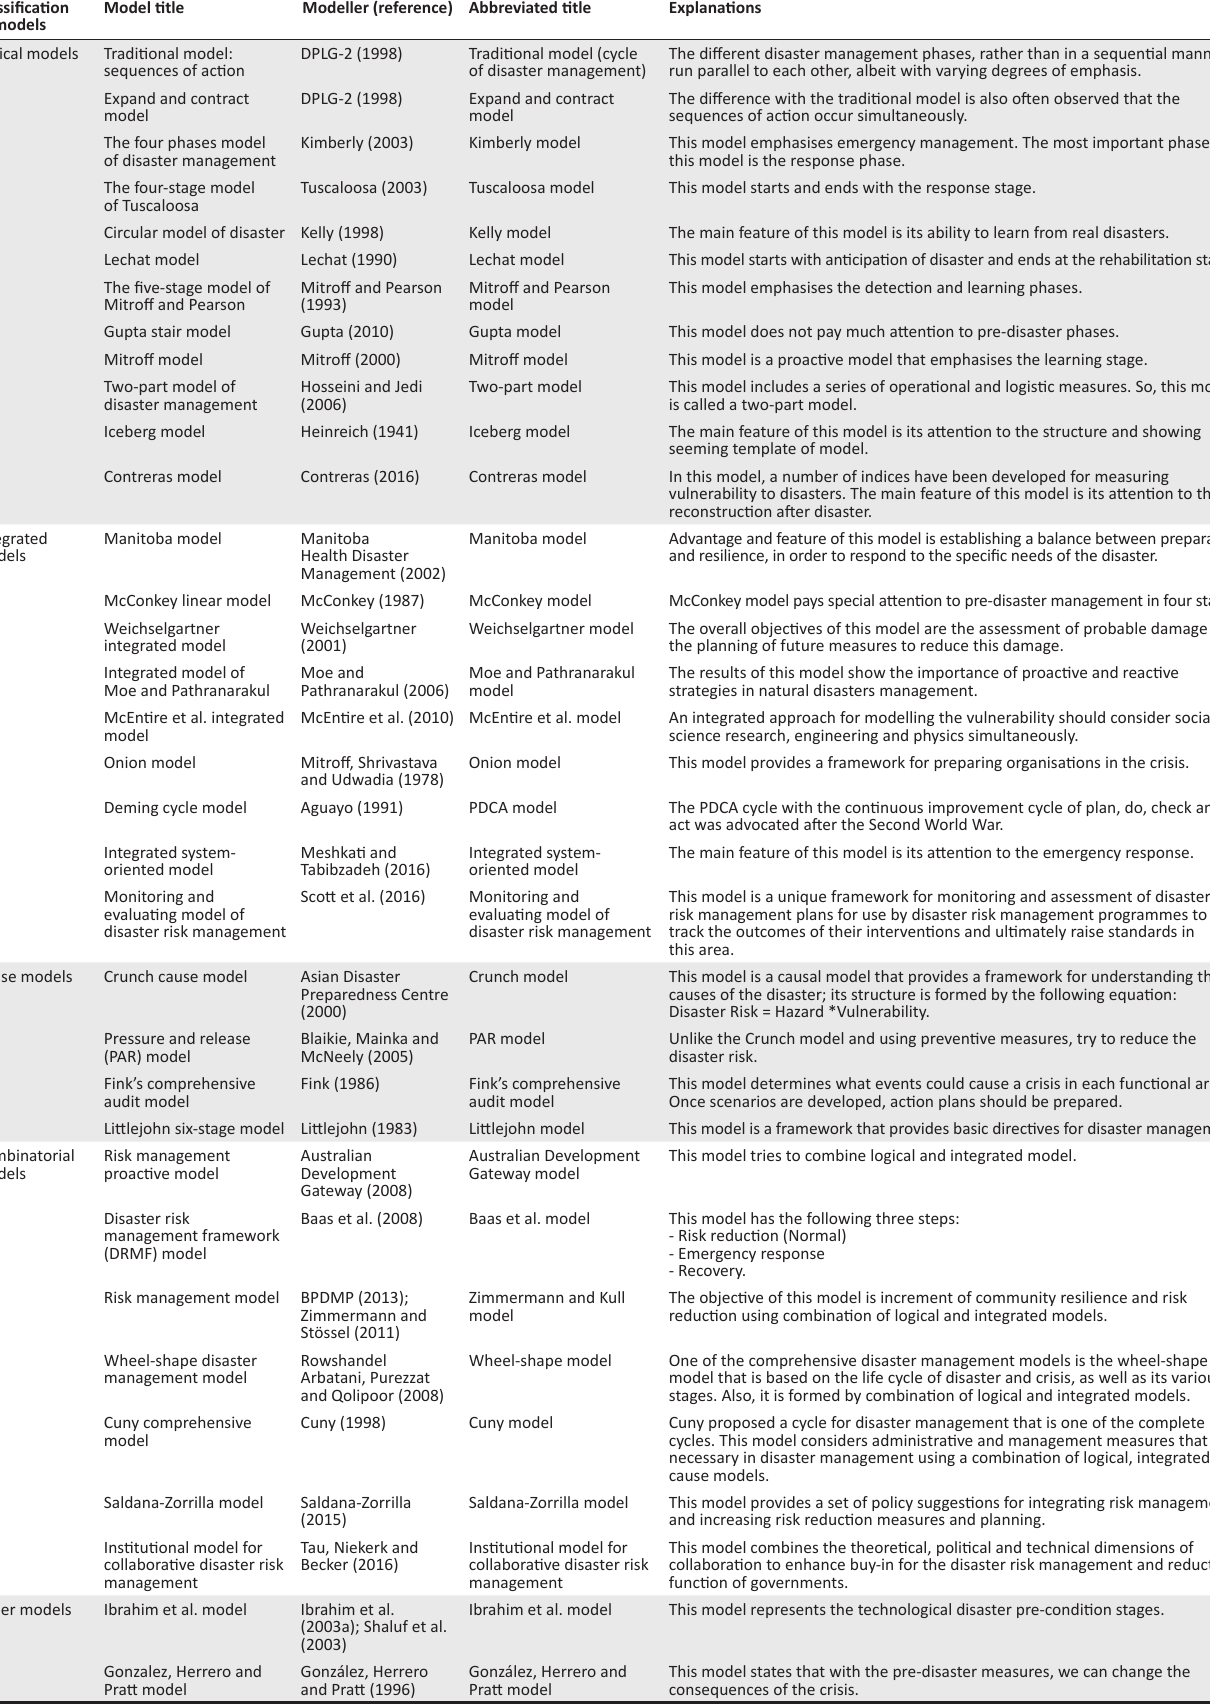
ExplanationsAbbreviated titleModeller (reference)Model titleClassification